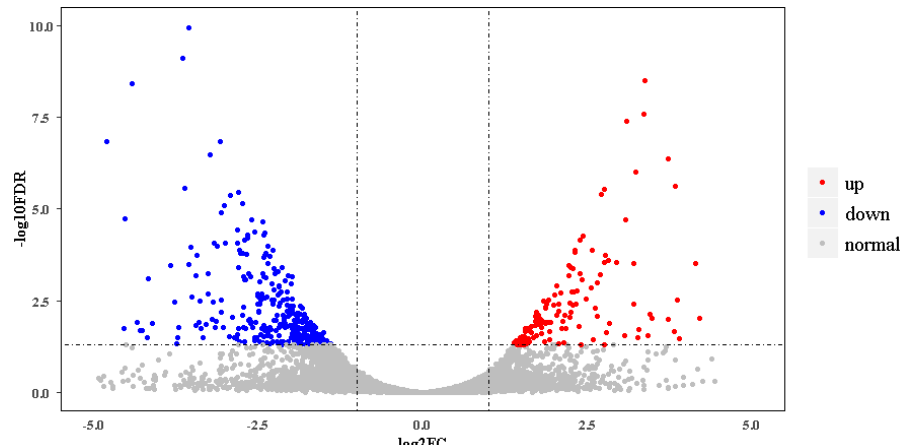
Figure 2. Volcano plot of di ff erentially expressed genes (DEGs) of black skins between breeding and nonbreeding season ibises. Upregulated and downregulated DEGs are shown as red and blue dots, respectively. The label of the x -coordinate log2FC is the log2 value of the fold change (FC) between breeding season ibises and nonbreeding season ibises. The label of the y -coordinate-log10FDR is the log10 value of the adjusted p